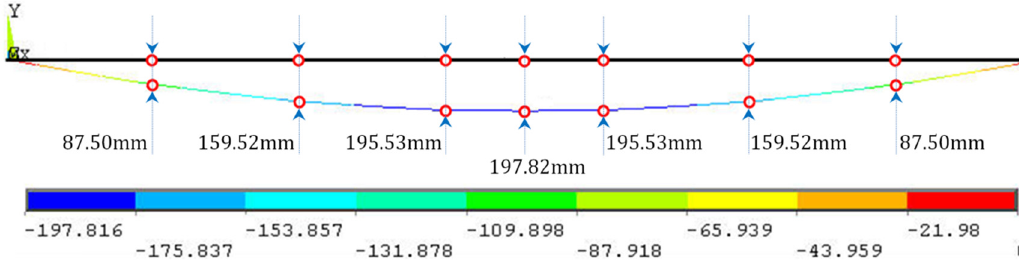
Figure 6: Nodal displacement of messenger wire after shape finding.